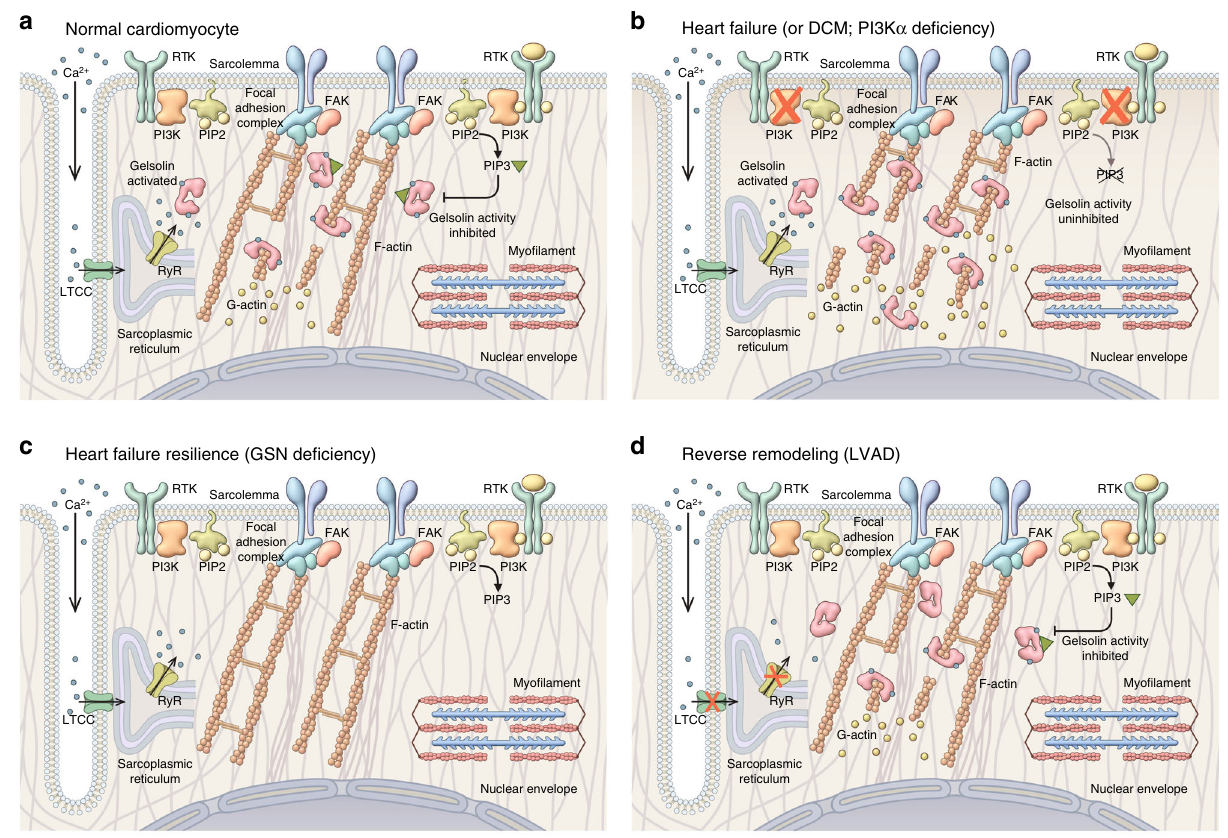
Fig. 8 Regulation of cytoskeleton density by PI3K α . a Normal myocyte: active PI3K α produces a pool of PIP3 that suppresses excessive activation of gelsolin (GSN) by Ca 2 + during Ca 2 + cycling leading to moderate gelsolin severing activity, normal cytoskeleton (F-actin) density, and good resilience to biomechanical stress. b Heart failure (e.g., dilated cardiomyopathy, DCM) or PI3K α -de fi cient model under pressure overload: low-levels or absent PI3K α activity leads to low levels of PIP3. Lack of PIP3 result in unhindered (high) gelsolin activation during Ca 2 + cycling, excessive breakdown of cytoskeleton (F- actin), low-cytoskeleton density, and poor resistance to biomechanical stress leading to DCM. c Heart failure resilience due to GSN de fi ciency: in the absence of gelsolin (GSN) and actin-severing activity associated with it, myocytes are able to maintain a high density of cytoskeleton (F-actin) resulting in high resilience to biomechanical stress and linked heart failure. d Reverse remodeling (LVAD): in the presence of left-ventricular assist device, heart contraction and associated Ca 2 + release are of much lower magnitude. Low levels of Ca 2 + during Ca 2 + cycling (release) result in less Ca 2 + -activation of gelsolin (inactive gelsolin) moderating gelsolin actin-severing activity that leads to improvement in cytoskeletal (F-actin) density, which in turn may drive reverse